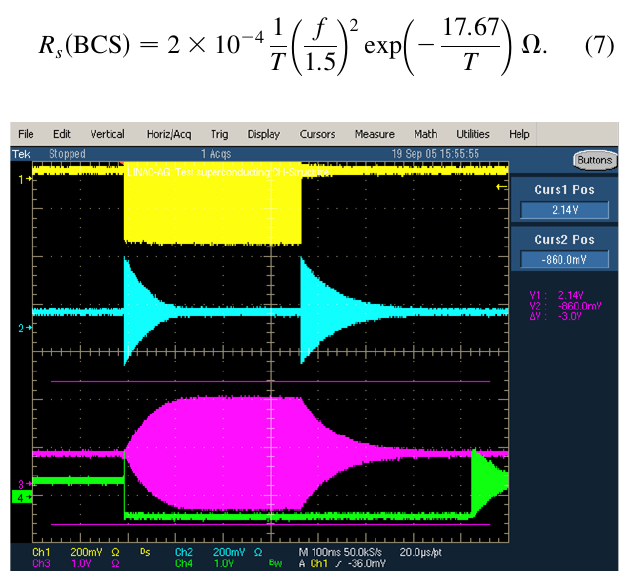
FIG. 29. (Color) Measurement of the transmission ( S ter) as a function of the frequency. The frequency bandwidth is 500 Hz and the y scale is 10 dB = division. At low field levels (forwarded power (cid:4) mW ). the cavity showed multipacting as it can be recognized by the flattop of the resonance curve.